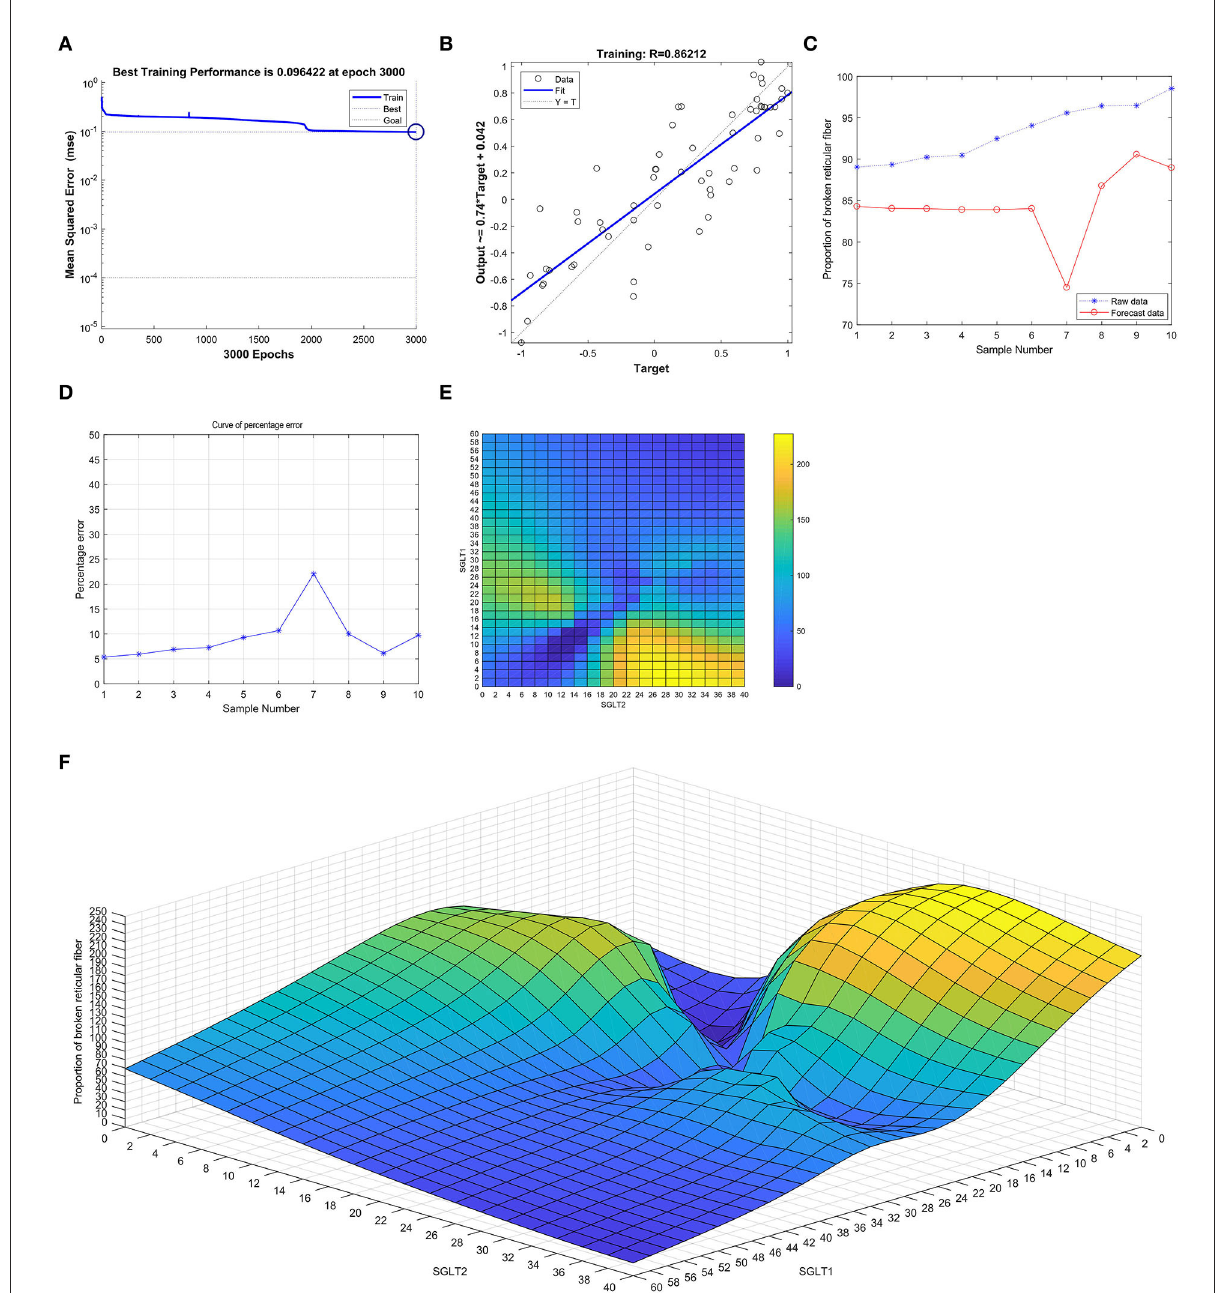
FIGURE10 Neural network prediction model and high-risk warning range of broken reticular fibers in the kidney based on the expression of SGLT1 and SGLT2. (A) After training the BP neural network of SGLT1 and SGLT2 for broken reticular fibers in the kidney, best training performance was 0.096422 at epoch 3,000. (B) Relativity was 0.86212. (C,D) By verifying the forecast data against the raw value, we found that there were large differences. (E,F) High-risk warning indicator of broken reticular fibers in the kidney: 0 < SGLT1 < 16 and 18 < SGLT2 < 40.